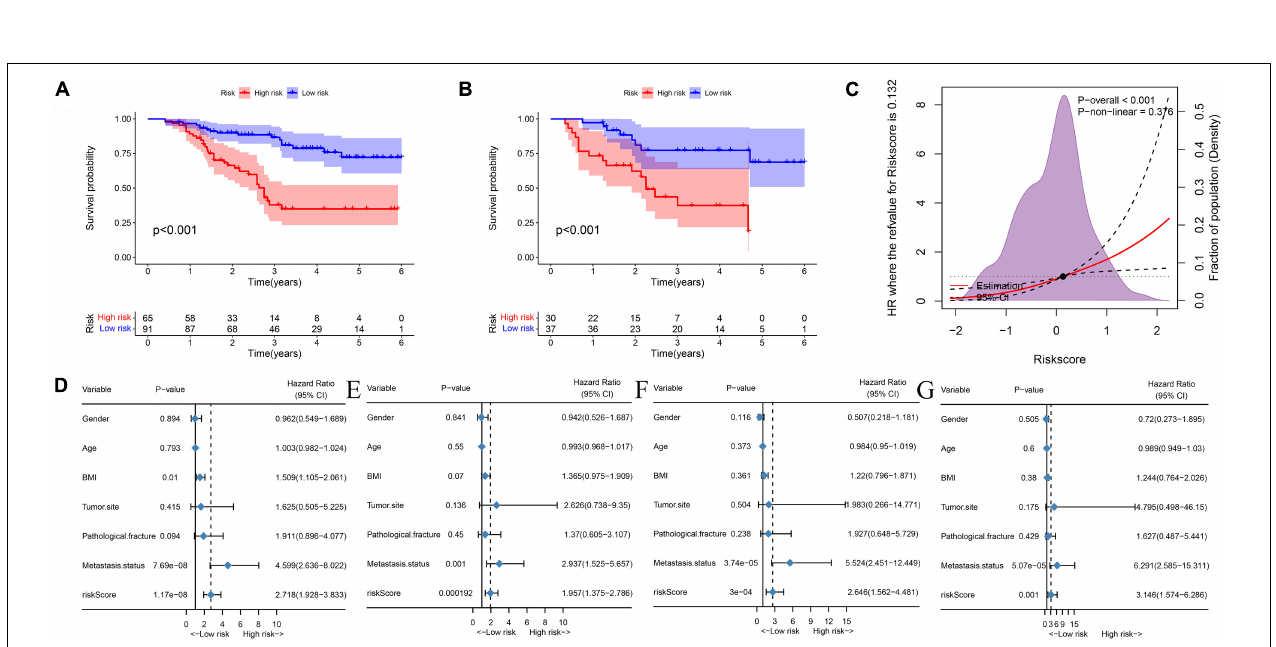
FIGURE 2 | NMRS has independent prognostic value in both the training and validation sets. (A) KM survival curves showing overall patient survival in the training set; (B) KM survival curves showing overall patient survival in the training set; (C) The overall cohort patient NMRS score and overall survival risk, restricted cubic splines indicated that the effect of NMRS as a continuous variable on overall survival risk was linear; (D) Results of univariate cox regression analysis of NMRS and clinical characteristics in the training set; (E) Results of multivariate cox regression analysis of NMRS and clinical characteristics in the training set; (F) Results of univariate cox regression analysis of NMRS and clinical characteristics in the validation set; (G) Results of multivariate cox regression analysis of NMRS and clinical characteristics in the validation set.